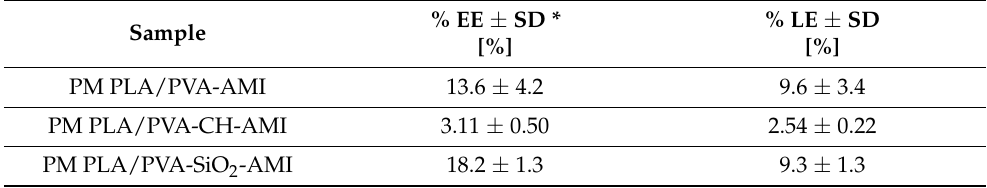
Table 5. Encapsulation and loading efficiency of the porous matrices modified with AMI.